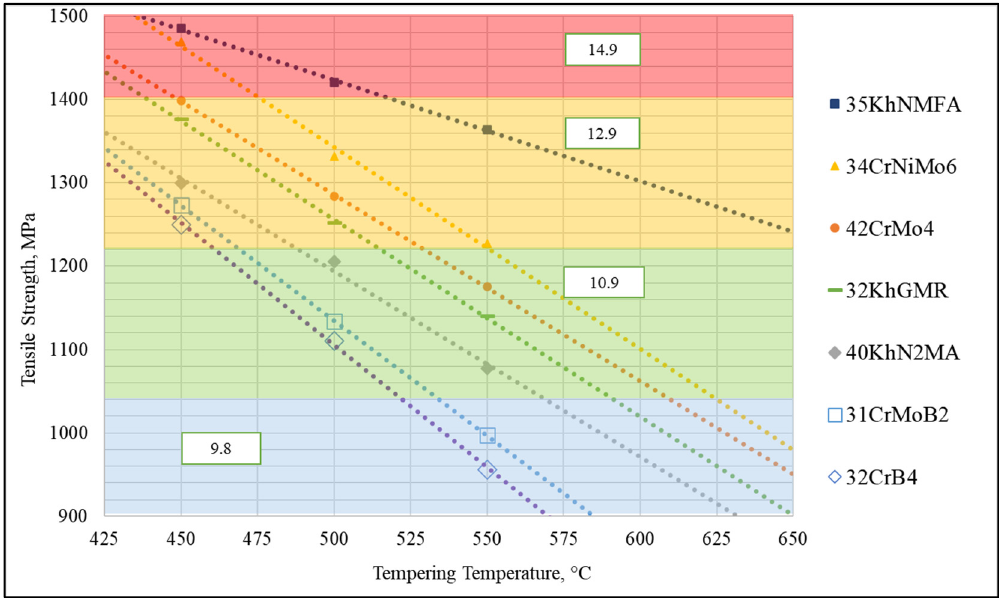
Figure 6. Dependences of the tensile strength of rolled steels of various grades on the tempering temperature.